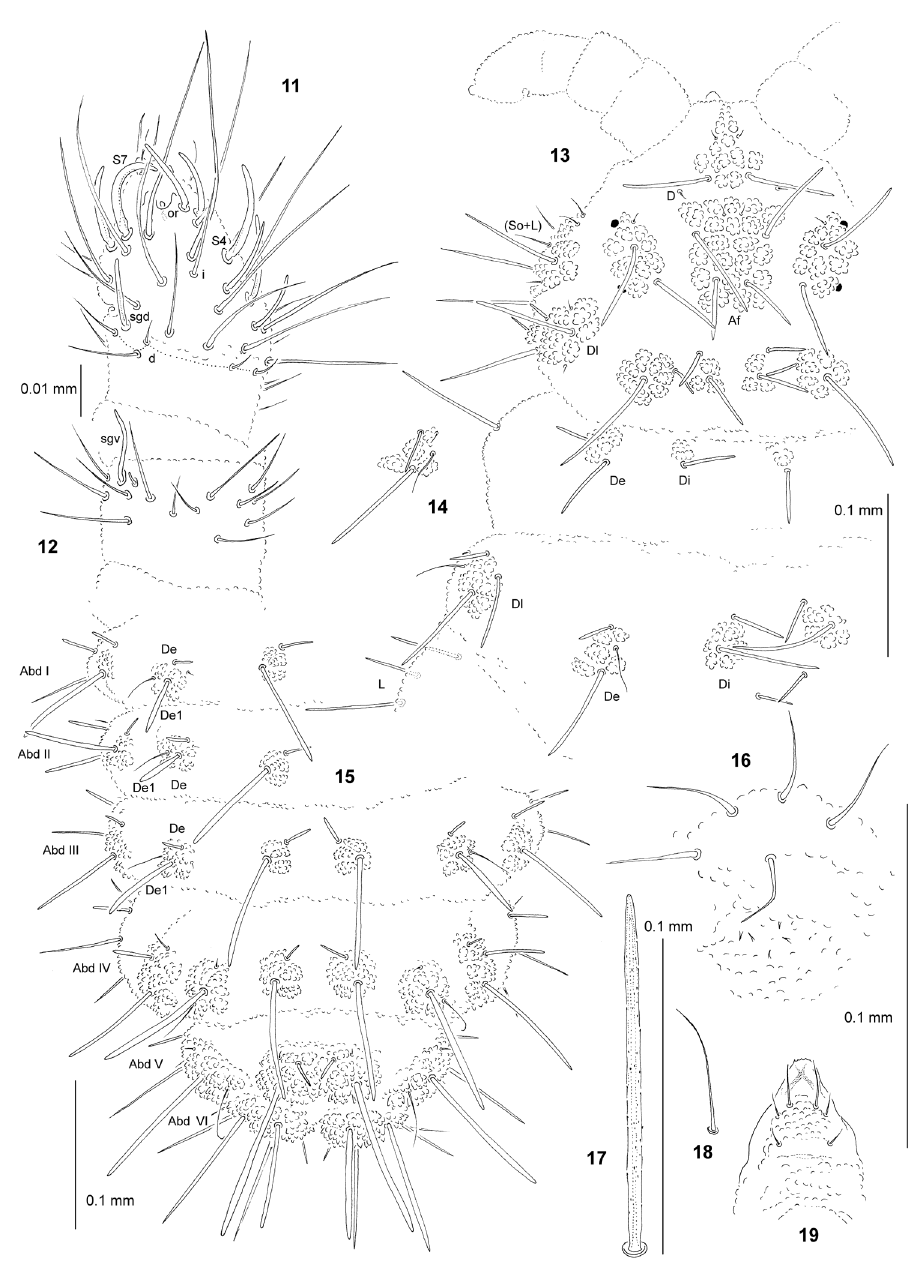
Figures 11–19. Endonura paracentaurea sp. n.: 11 dorsal chaetotaxy of Ant III–IV 12 ventral chaetotaxy of Ant III 13 chaetotaxy of head and Th I–II (holotype), dorsolateral view 14 chaetotaxy of tubercle De of Th III 15 dorsal chaetotaxy of Abd I–VI 16 furca rudimentary 17 chaeta Di1 of Abd V 18 sensillum of Abd V 19 chaetotaxy and ventral sclerifications of